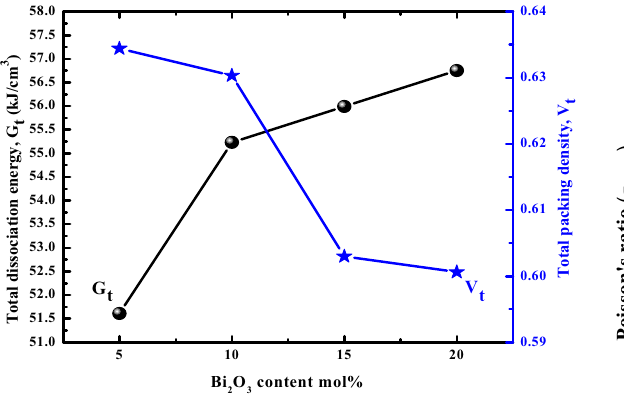
Figure 2: Variation of packing density and dissociation energy as a function of Bi 2 O 3 content mol% for all S1 – S4 glasses.